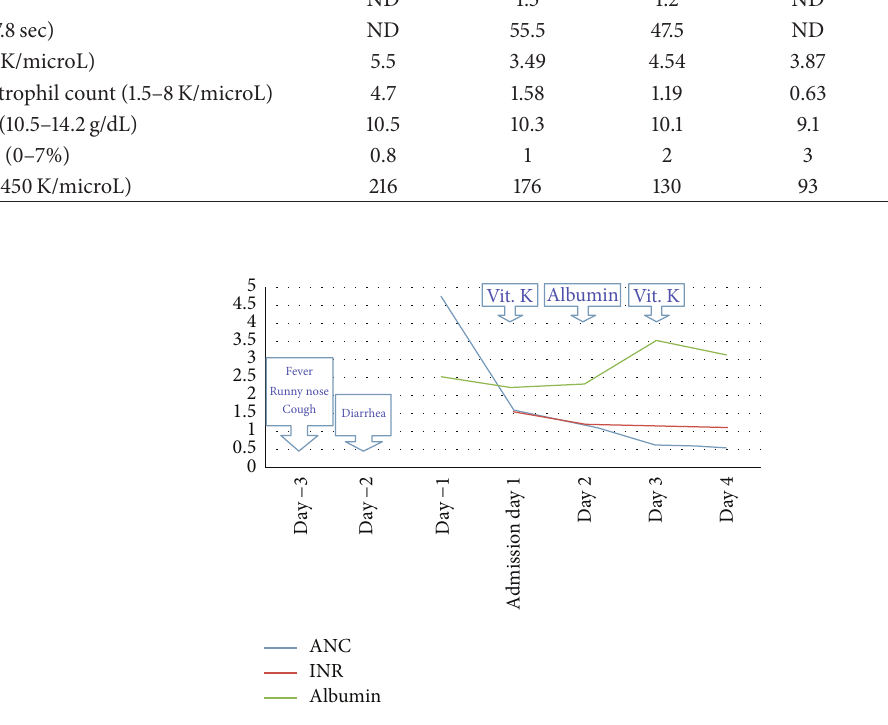
Figure 1: Hospital course diagram. ANC: absolute neutrophil count; INR: international normalized ratio. The 𝑥 -axis represents units for albumin (g/dL) and ANC